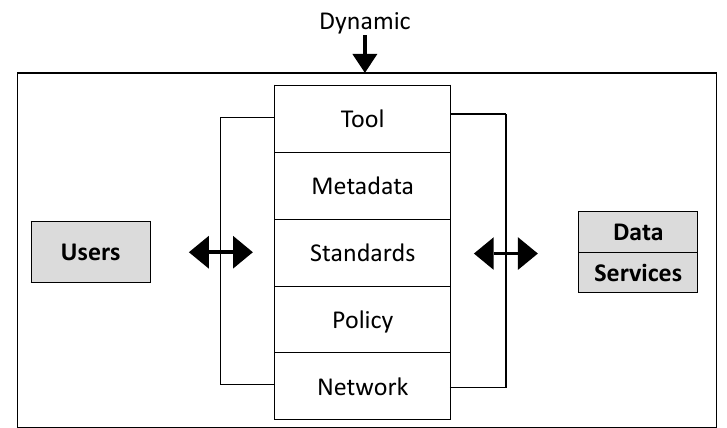
Figure 1. Basic components of an SDI. Source: adapted from